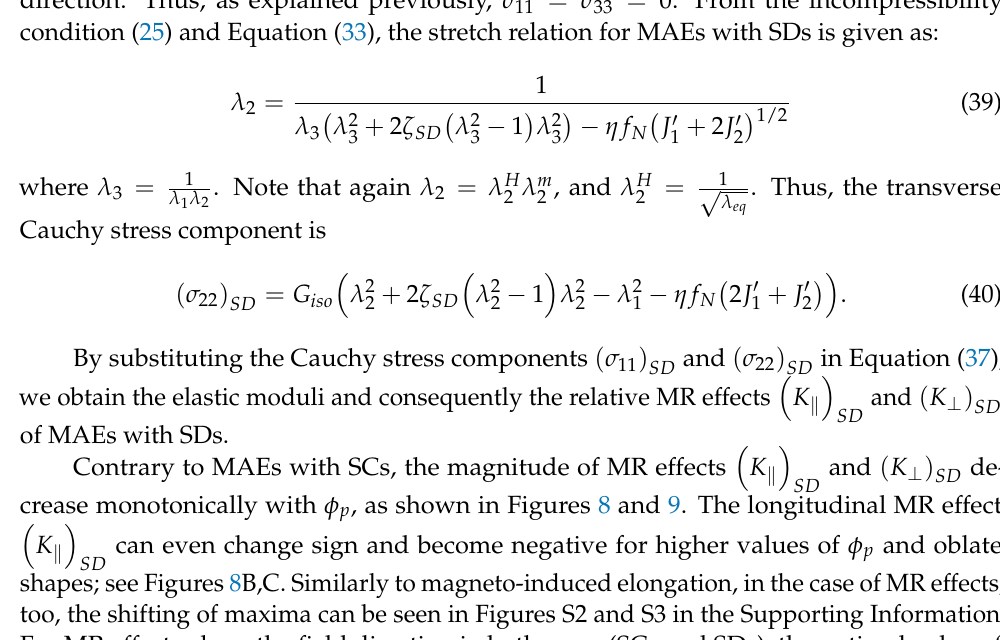
Figure 7. The magneto-rheological effect ( K ⊥ ) stretched perpendicular to the field direction at constant | (cid:126) H 0 | = 470 kA/m, G m = 17 kPa. ( A ) φ = 0.15, ( B ) φ = 0.2, ( C ) φ =